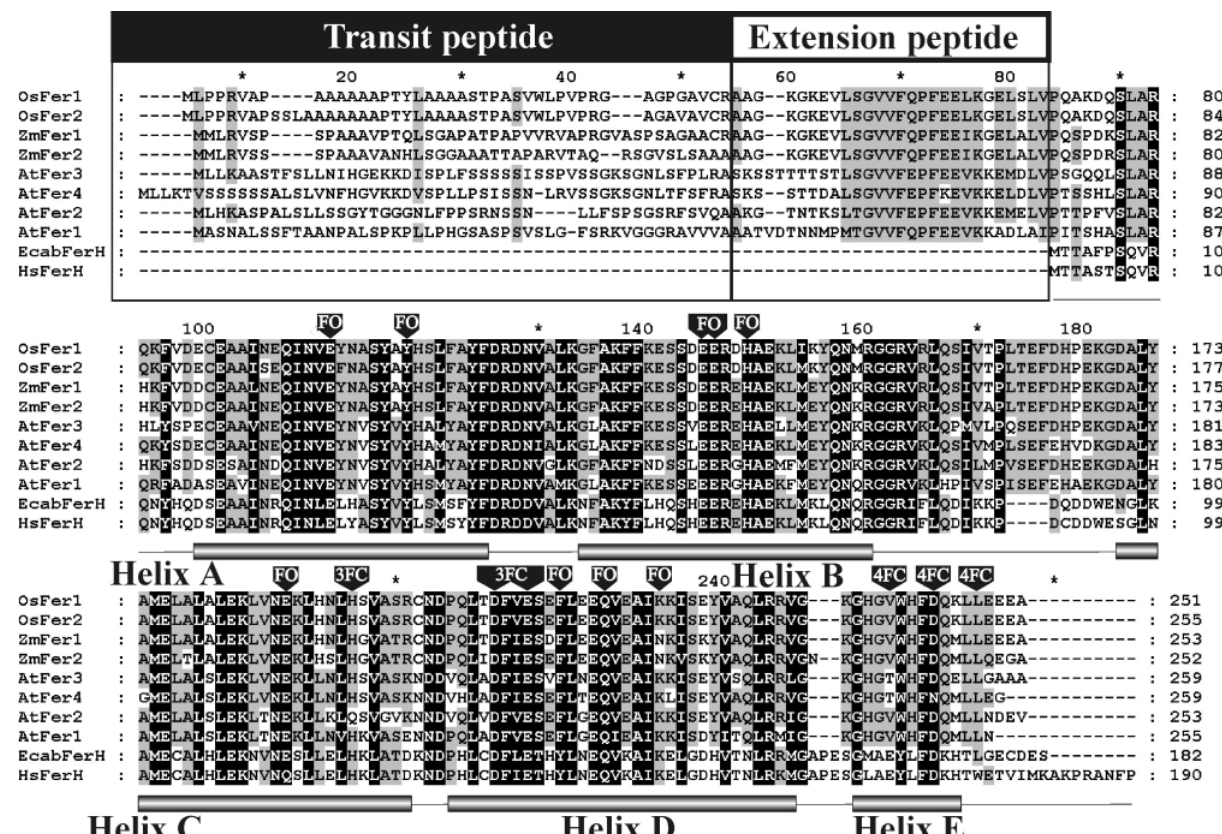
Figure 7 - ClustalW multiple alignment of the Ferritin proteins. The figure shows the structure of plant Ferritins of Oryza sativa (OsFer1: AAM74942; OsFer2: AAM74943), Zea mays (ZmFer1: CAA58146; ZmFer2: CAA58147), Arabidopsis thaliana (AtFer1: CAA63932; AtFer2: CAC85498; AtFer3: CAC85399; AtFer4: CAC85400) and compares them with the mammalian homologues of Homo sapiens heavy chain (HsFerH: CAA25086) and Equus caballus heavychain(EcabFerH:AAM51631).Atransitpeptideandanextensionpeptidearedelimitedinthecorrespondingboxes.Alphahelixesarepo- sitioned below the alignment block according to the extensions from the HsFerH. Some functional aminoacids are pointed above the alignment block in the positions that they occur in the HsFerH. In this protein they are involved in the Ferroxidase catalytic center (FO), constitution of the 3-fold channel (3FC) and the 4-fold channel